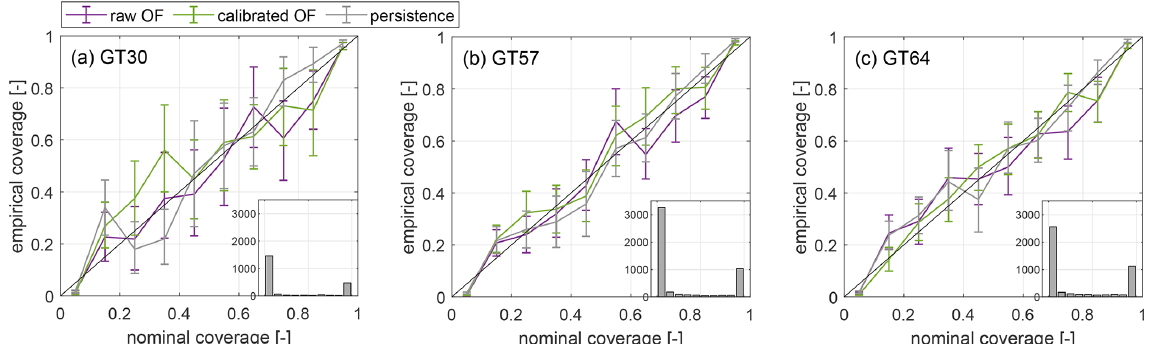
Figure 10. Reliability diagrams of the raw observer-based forecast (purple), the calibrated observer-based forecast (green) and persistence (grey) for turbines GT30, GT57 and GT64. The 95% confidence intervals are visualized as error bars. The diagonal black line indicates perfect reliability. Histograms show the number of valid forecasts per quantile step for the calibrated